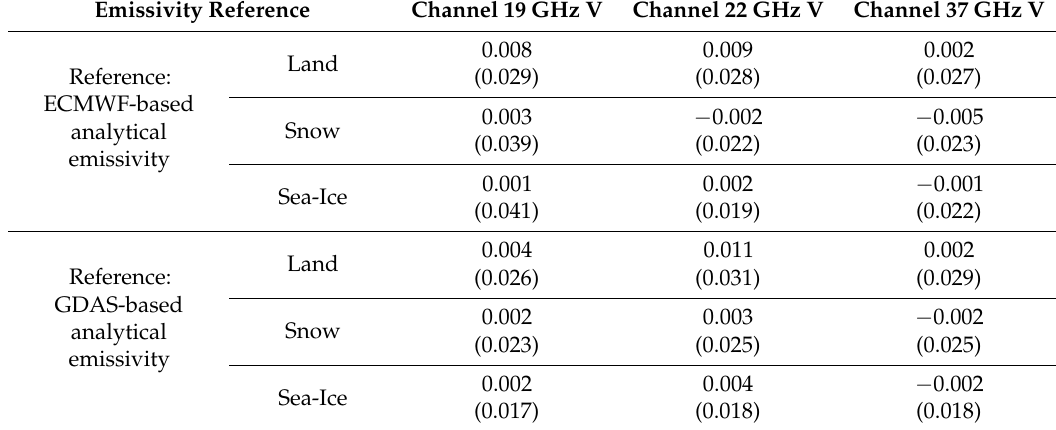
Table 2. Performances of MiRS-based emissivities for three channels (vertical polarization) from DMSP-F16 SSMI/S, when considering ECMWF-based and GDAS-based analytically computed emissivities as references. Performances are shown in terms of bias and (standard deviation) for land, snow and water